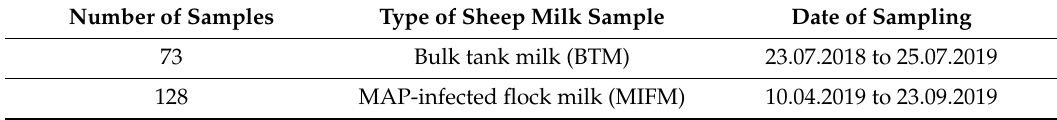
Table 1. The number of milk samples in each category of BTM and MIF and date of sampling. Number of